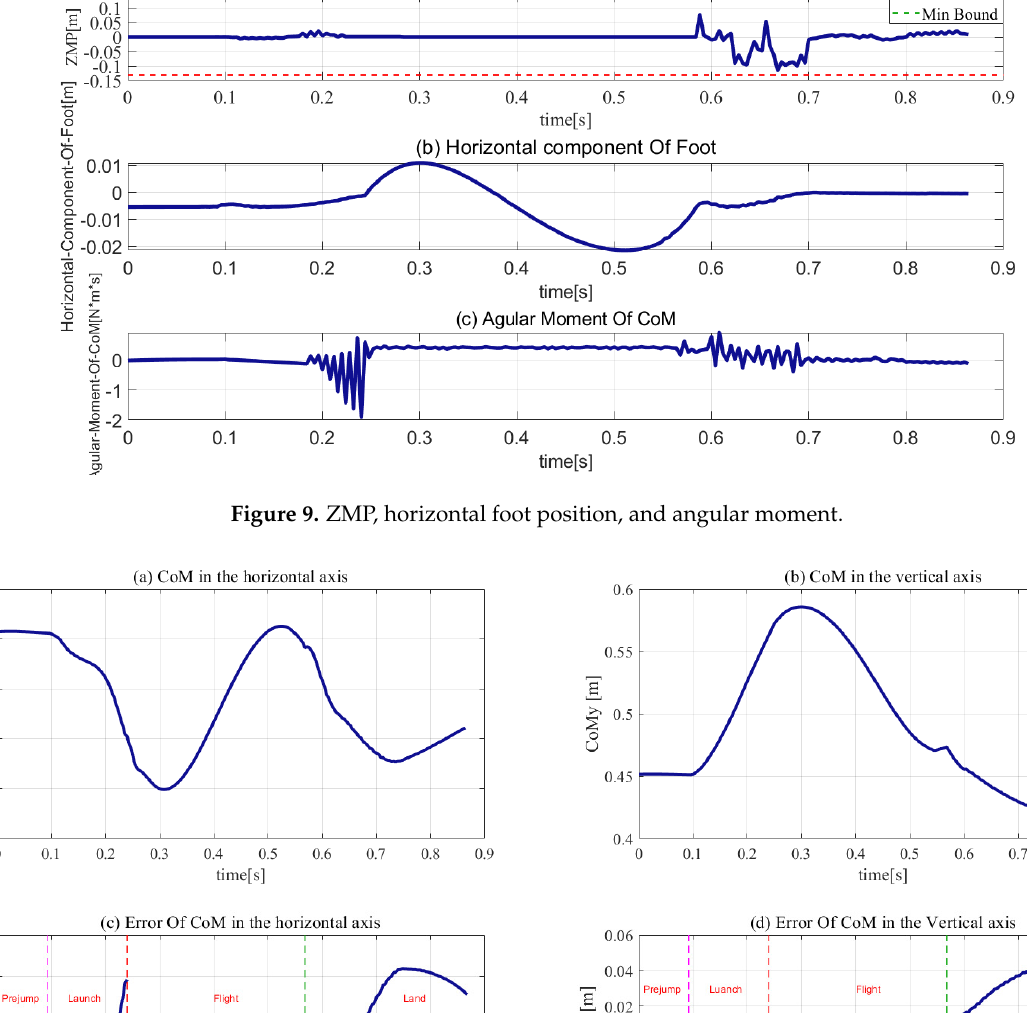
Figure 9. ZMP, horizontal foot position, and angular moment.